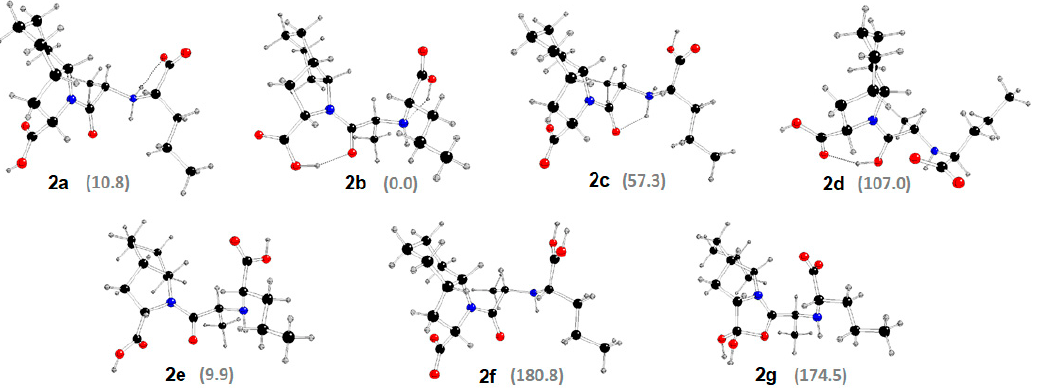
Figure 3. Optimized geometry of L -proline, structure 1a, b and c with corresponding relative Gibbs free energies at 298 K (in kJ/mol) in parentheses ( C —black, N —blue, O – red, H —grey).